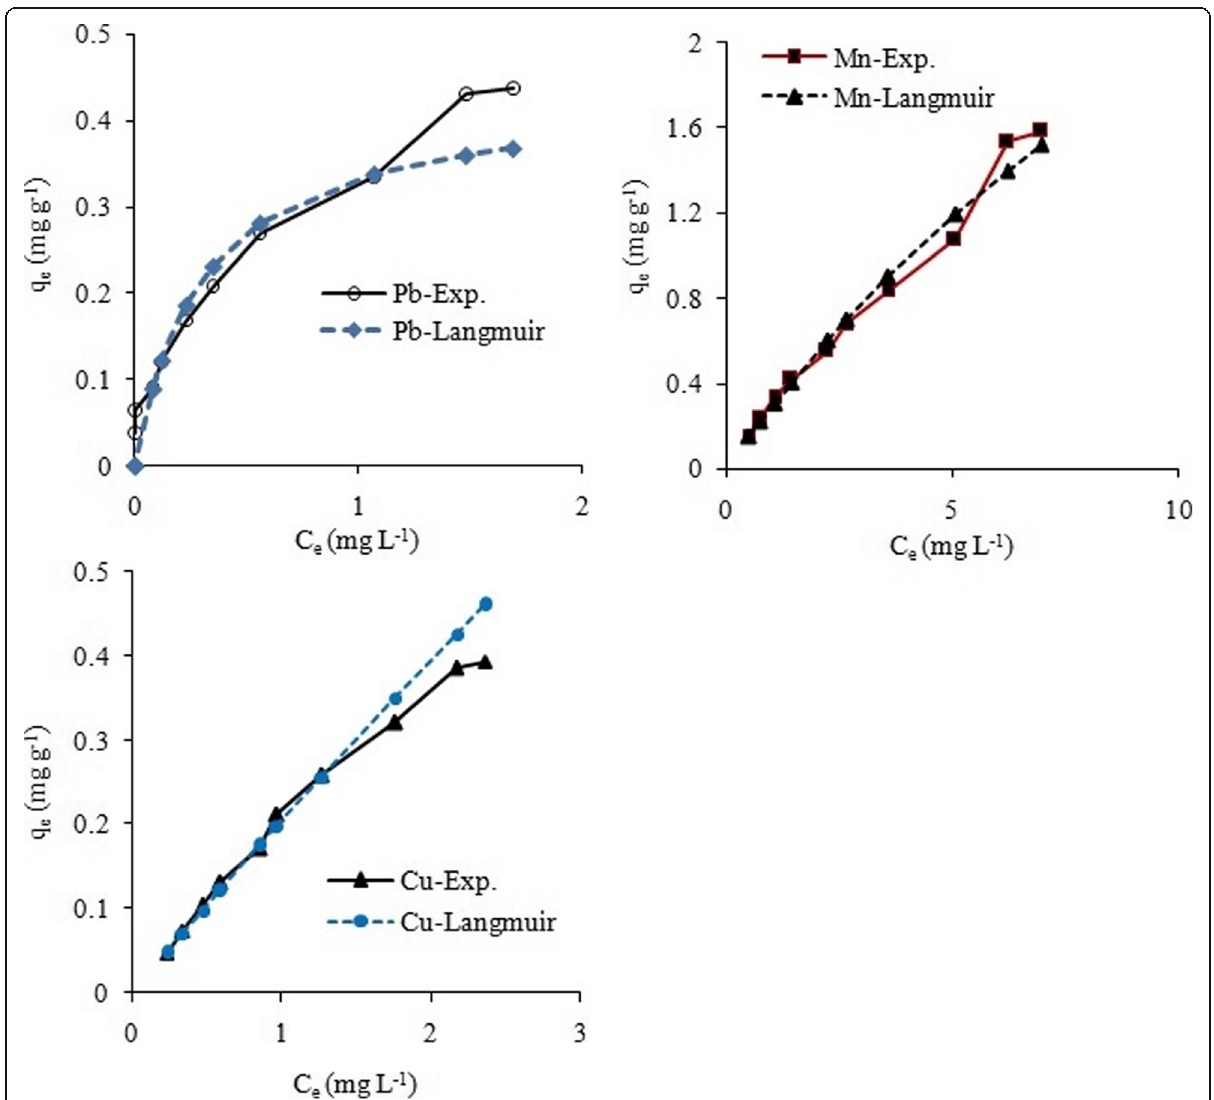
Fig. 4 Experimental and predicted adsorption of the heavy metals onto PWB in landfill leachate using Langmuir-1 expression